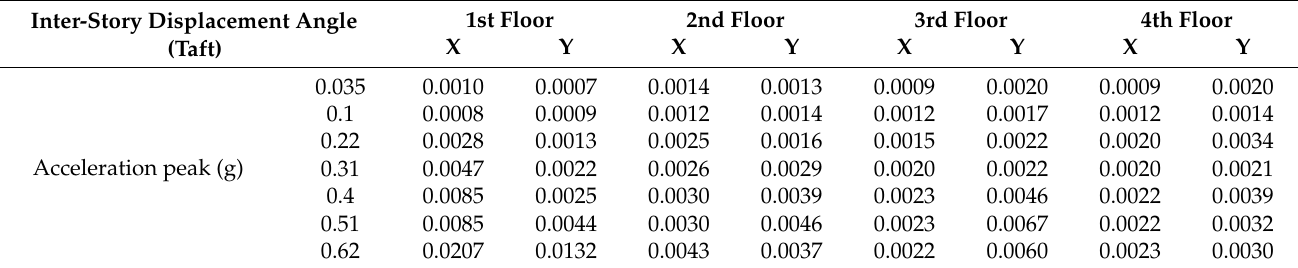
Table 7. Inter-story displacement angle (Taft).